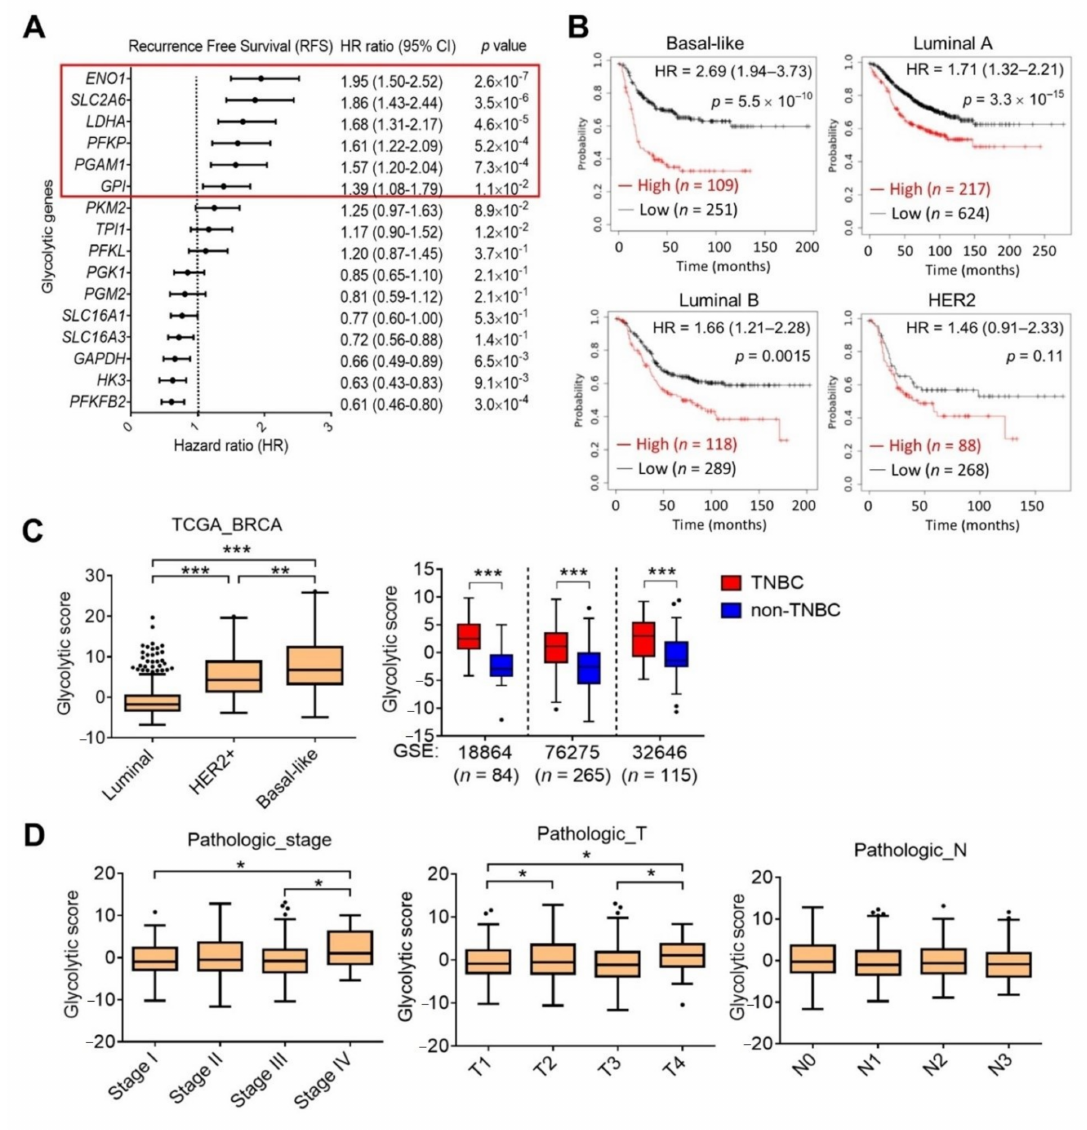
Figure 2. Upregulation of the glycolysis signature confers a poor prognosis in triple-negative breast cancer patients. ( A ) Forest plot showing hazard ratio (HR) estimates and 95% confidence intervals (CI) of 14 glycolysis-related genes and recurrence-free survival in breast cancer patients. The six selected genes as a glycolysis signature are shown in red. ( B ) Kaplan-Meier curve analysis of recurrence-free survival probability of breast cancer patients stratified by glycolysis signature expression. ( C ) Expression levels of the glycolysis signature in breast cancer patients according to TCGA and GEO (GSE18864, GSE76275, and GSE32646) datasets. ** p < 0.01, and *** p < 0.001 as determined by unpaired t -tests. ( D ) Box plot showing the glycolysis signature score grouped by pathologic stage, tumor grade, and lymph node status. * p < 0.05, ** p < 0.01, and *** p < 0.001 as determined by an